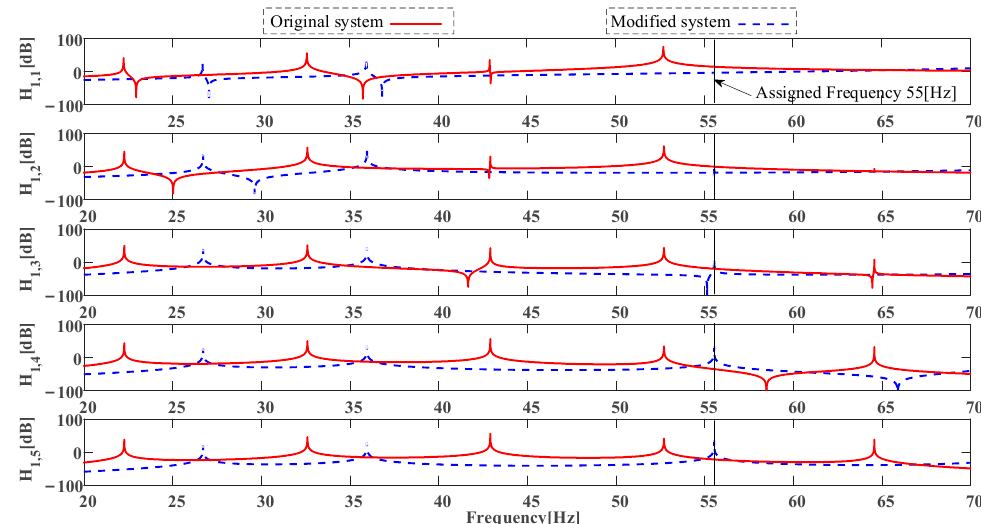
Figure 13. Original FRFs and FRFs after the addition of supporting